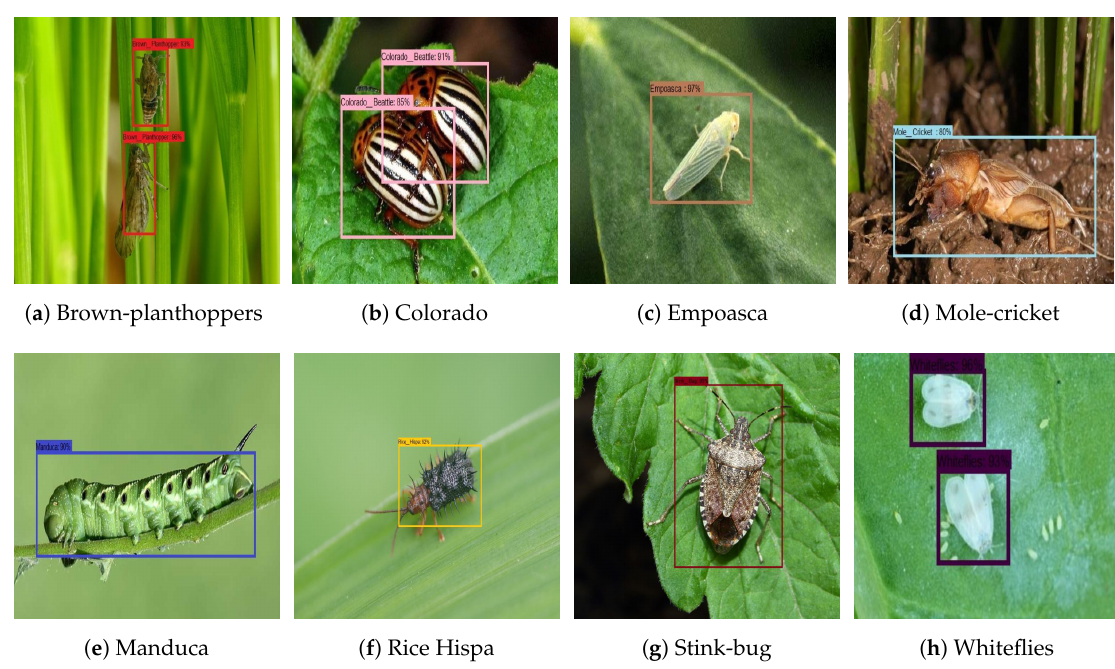
Figure 7. Garden and farm field Insect Identification.